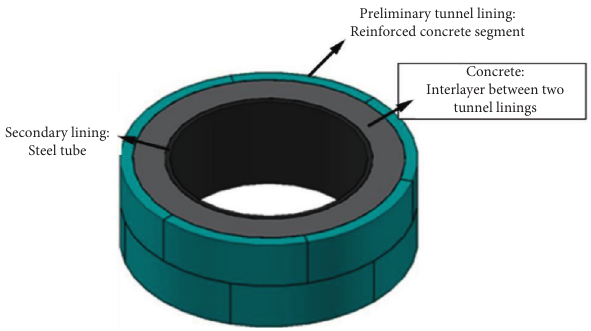
Figure 1: Concrete confined by two tunnel